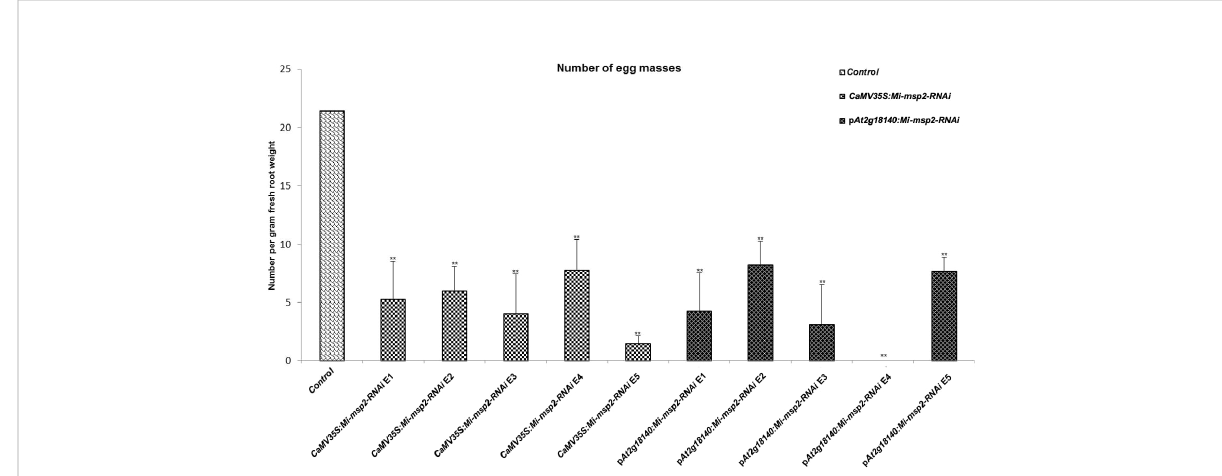
plants were compared. Morphometric analyses were conducted toassesstheeffectofsilencingonthegrowthpatternsbymeasuring the average surface area ( m m 2 ) and the average width ( m m) of the feedingfemales.Twenty females wereselectedfromeach of the fi ve RNAi lines of CaMV35S::Mi-msp2-RNAi and p At2g18140::Mi- feedingon control plants(Figure6C). The reduction in the average